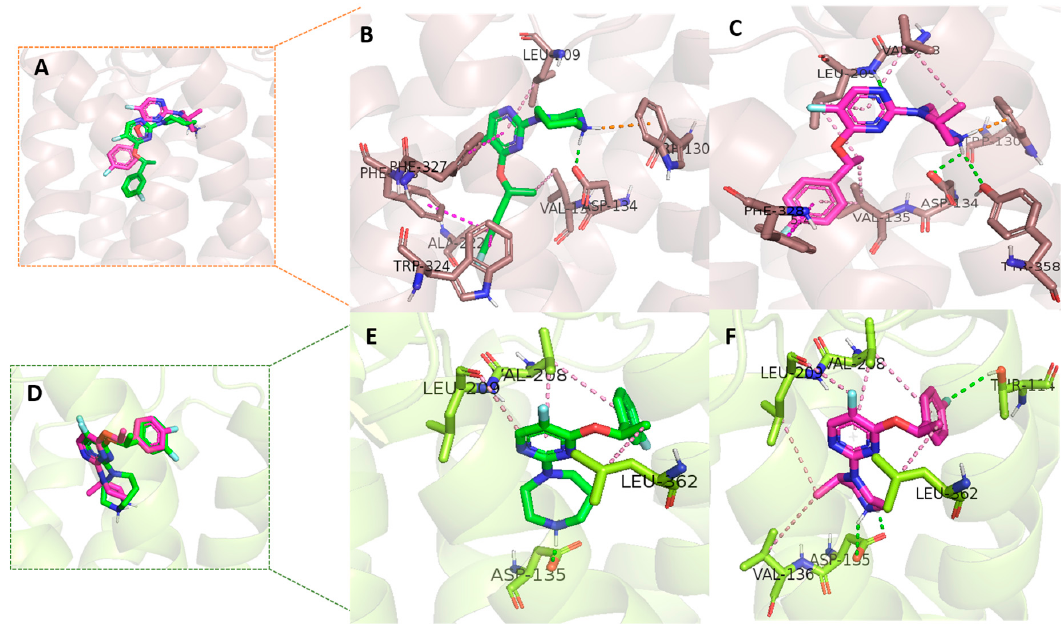
Figure 3. Interactions of 10a and 8 inside the 5-HT 2C and 5-HT 2B receptors. Ligands 10a and 8 are shown in green and magenta color stick format. 5-HT 2C (wheat color) and 5-HT 2B (green color) protein structures are shown in cartoon format. Hydrogen bond, π -cationic, π – π stacking, and hydrophobic interactions are shown in green, orange, dark pink, and light pink dash line format. ( A ) Overlap of 10a and 8 inside 5-HT 2C protein. ( B ) Interactions between ligand 10a and the 5-HT 2C receptor. ( C ) Interactions between ligand 8 and the 5-HT 2C receptor. ( D ) Overlap of 10a and 8 inside 5-HT 2B protein. ( E ) Interactions between ligand 10a and the 5-HT 2B receptor. ( F ) Interactions between ligand 8 and the 5-HT 2B receptor.